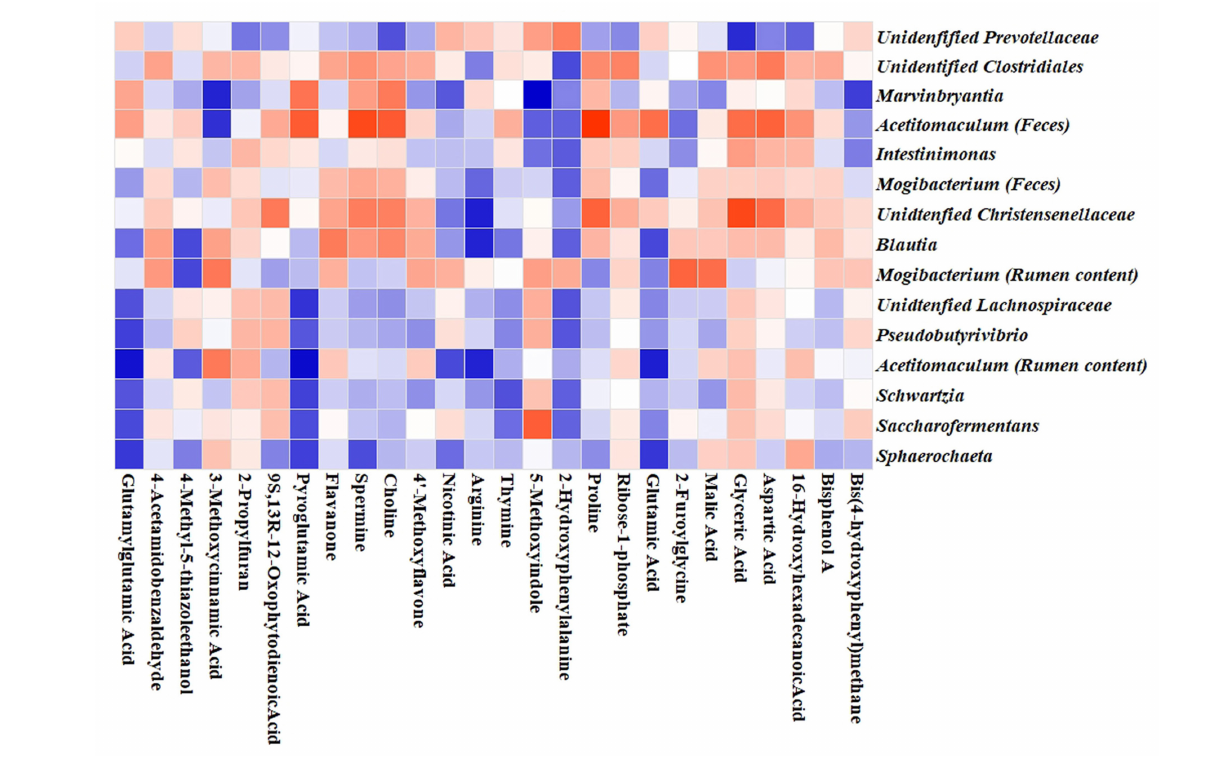
FIGURE 4 | Correlation heatmap between microbiota genera and the altered metabolites. Pearson correlation between metabolites and microbiota genera in ruminal content and feces affected by NCG supplementation. Blue squares indicate negative correlations, and red squares indicate positive